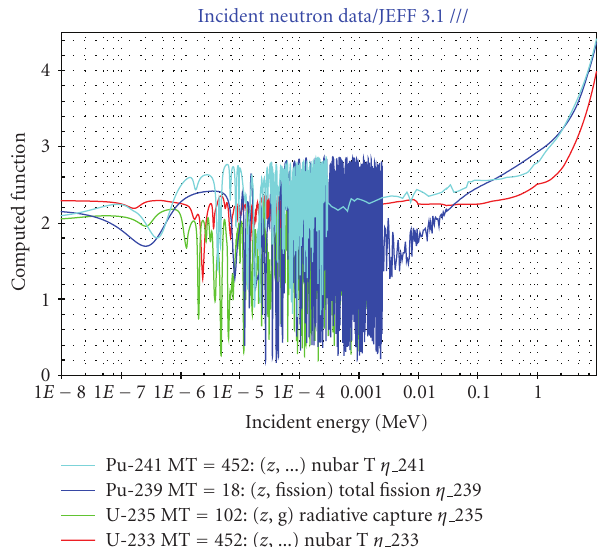
Figure 1: The η -factor for U-233, U-235, Pu-239, and Pu-241. Made with the JANIS data viewer (http://www.nea.fr/janis), based on JEFF-3.1 data. Note that U-235 has the lowest η of all isotopes in both the thermal and the fast range. For Pu-239, the breeding potential rapidly increases above 50